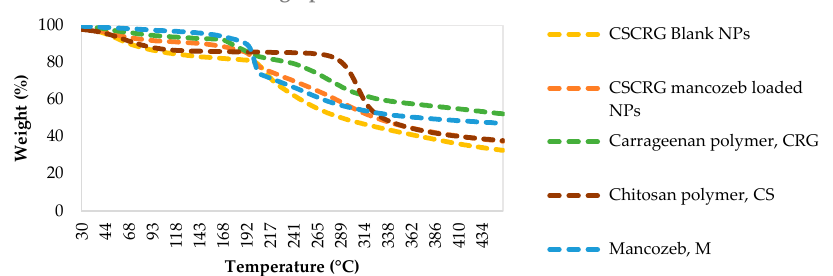
Figure 6. TGA thermograms of blank and mancozeb-loaded nanocomposites along with raw poly- mers and mancozeb.